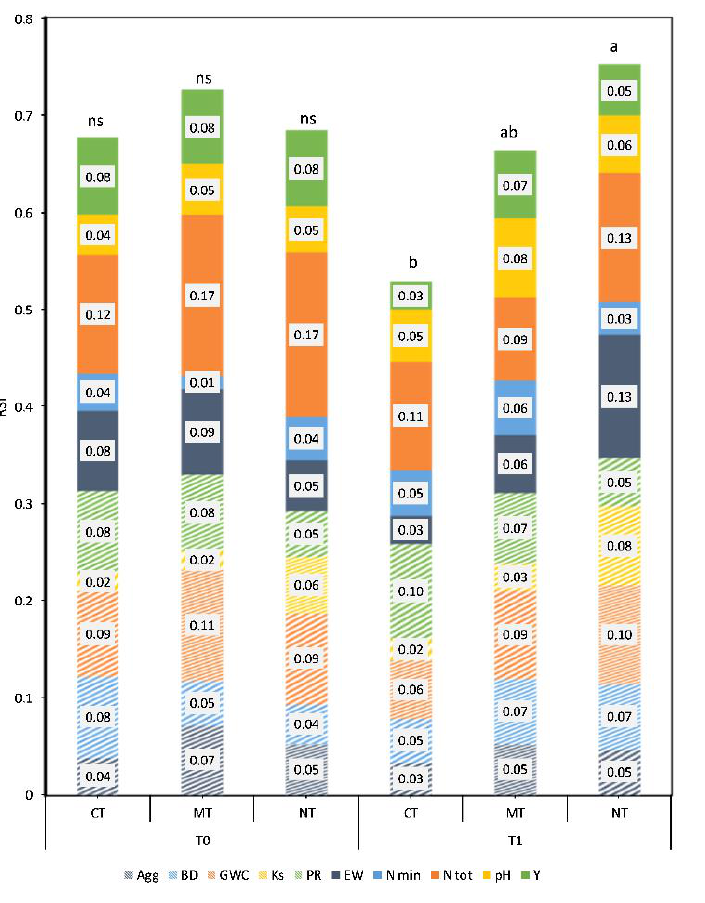
Figure 3. Average RSIs and the contribution of each parameter under different tillage systems in different years. Agg—aggregate stability; BD—bulk density; GWC—gravimetric water content; Ks —saturated hydraulic conductivity; PR—penetration resistance; EW—earthworm density; N min—mineral nitrogen; N tot—soil total nitrogen; Y—yield; CT—conventional tillage; MT—minimum tillage; NT—no tillage. Different letters represent significant differences of the global treatment RSI at p <